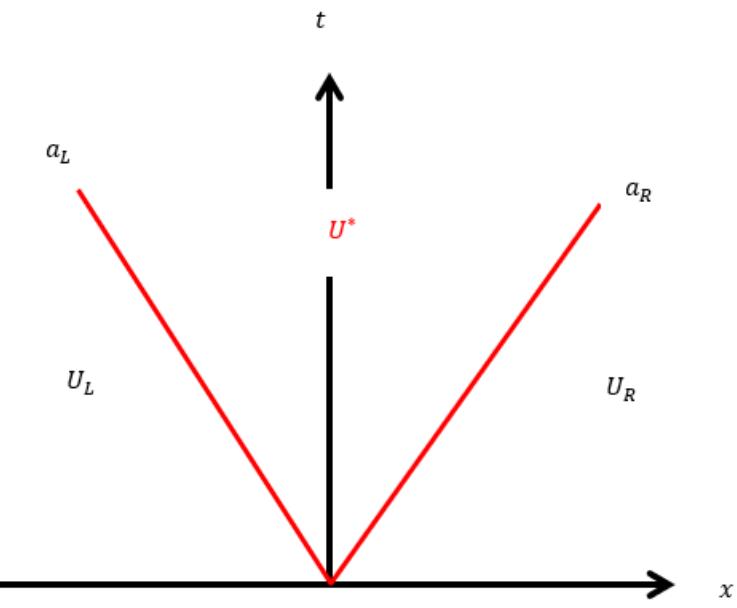
Figure 8. Approximate HLL solver depicting the star region separated by two waves.